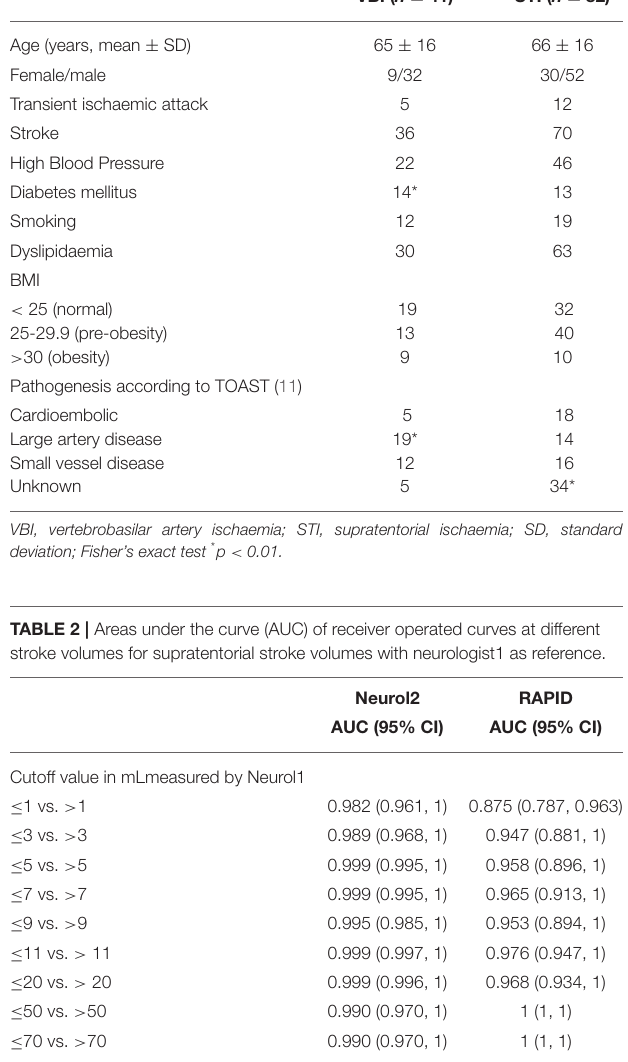
TABLE 3 | The AUC of receiver operated curves at different stroke volumes for supratentorial stroke volumes with RAPID as Patients with VBI ( n = 41)